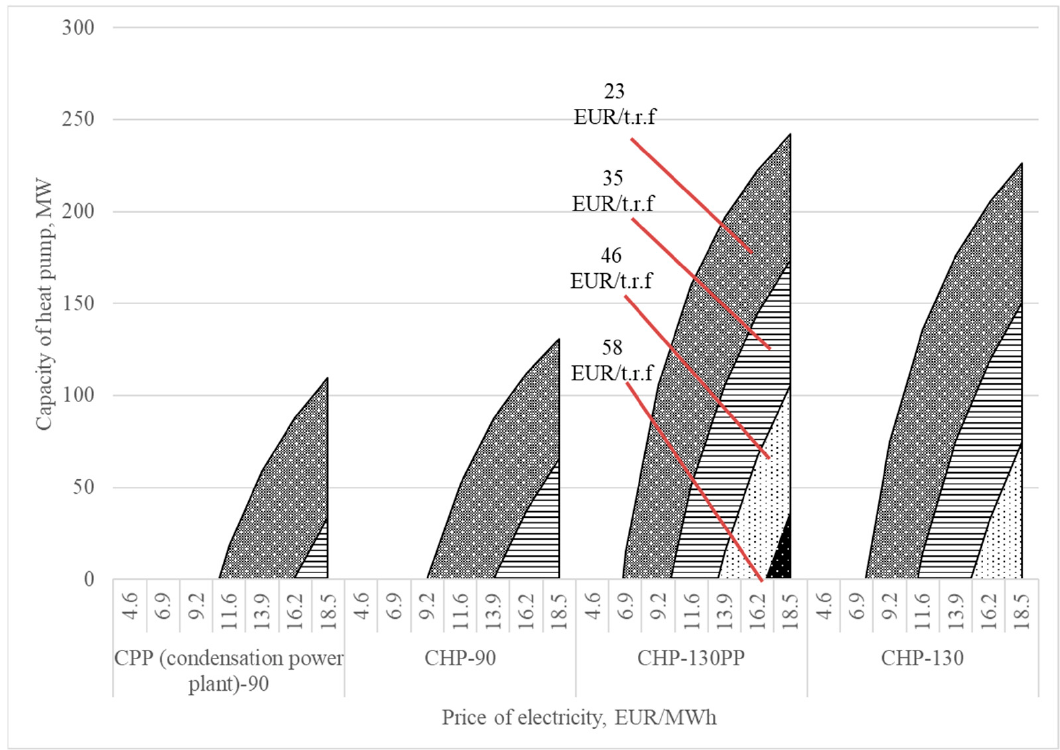
Figure 11. The range of permissible HP capacities with a TPP capacity of 90–130 MW.